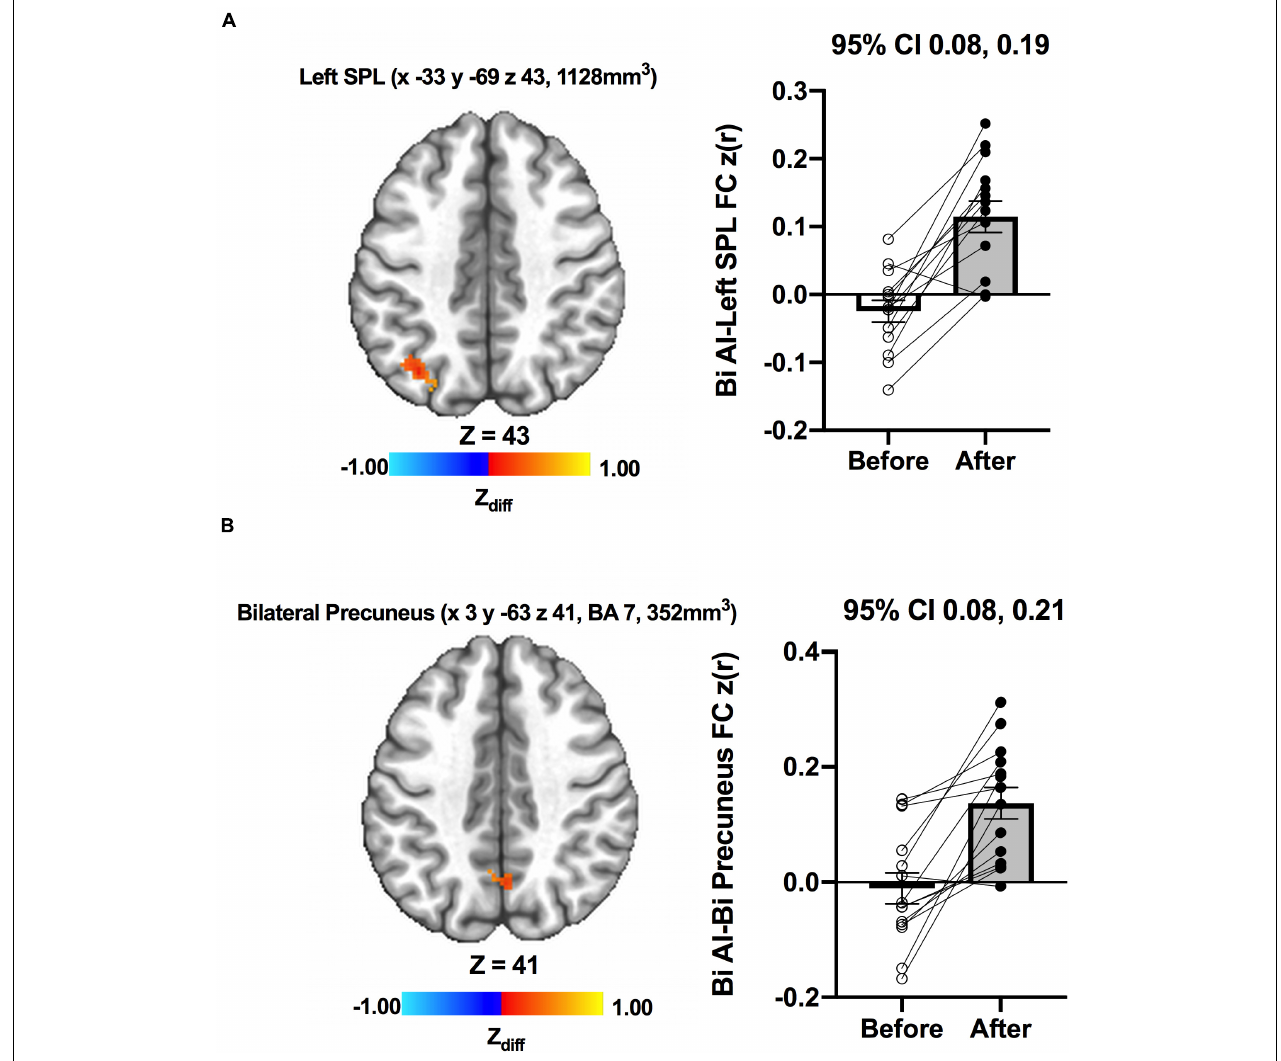
FIGURE 3 | Increases in functional connectivity between the anterior insula and (A) left superior parietal lobe, inferior parietal lobe, and (B) bilateral precuneus were found after exercise training in MCI individuals. Adjacent bar graphs indicate the connectivity between the anterior insula and respective regions ( ± SEM) before and after exercise training. 95% CI above bar graphs indicates 95% confidence interval in the difference from before to after exercise